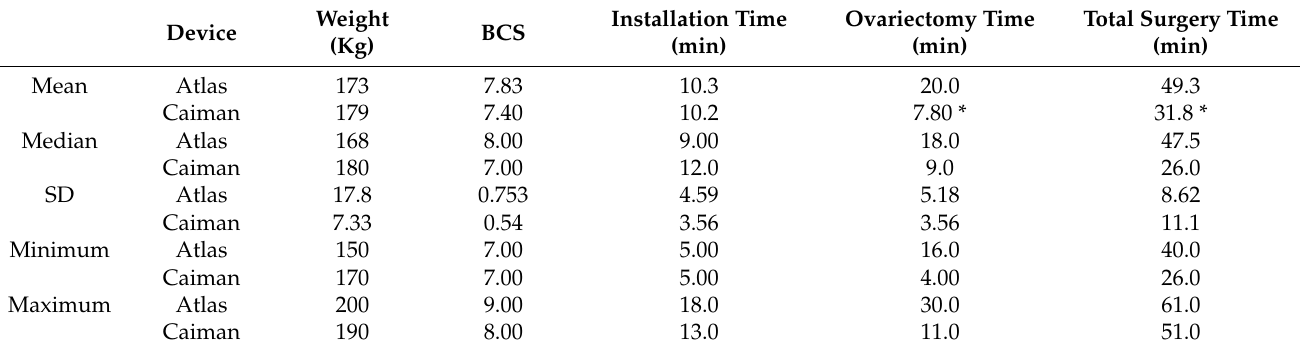
Table 1. Summary of the mean, median, standard deviation, and range for the weight, BCS, installa- tion time, ovariectomy time, and total surgery time. (*) significant differences detected ( p <